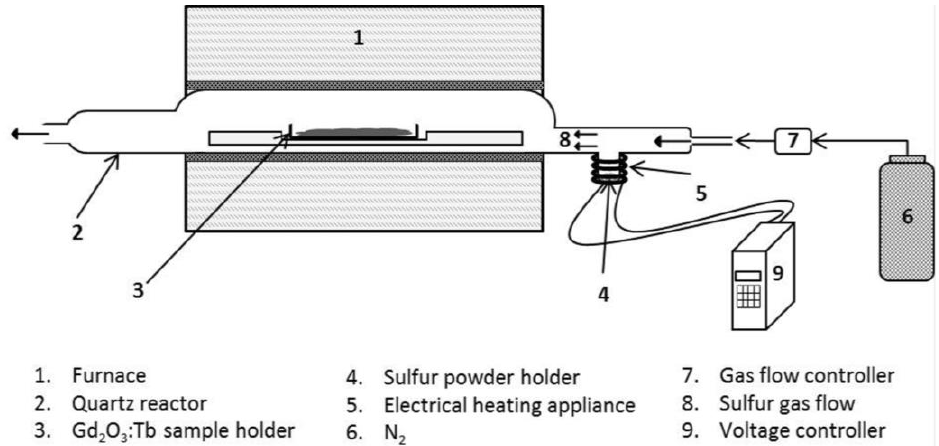
Figure 6. A schematic representation of the sulfidation process consisting of gadolinium-based hydroxides, hydrocarbonates, or oxides exposition to a sulfur atmosphere (image taken with the permission of reference [77]).